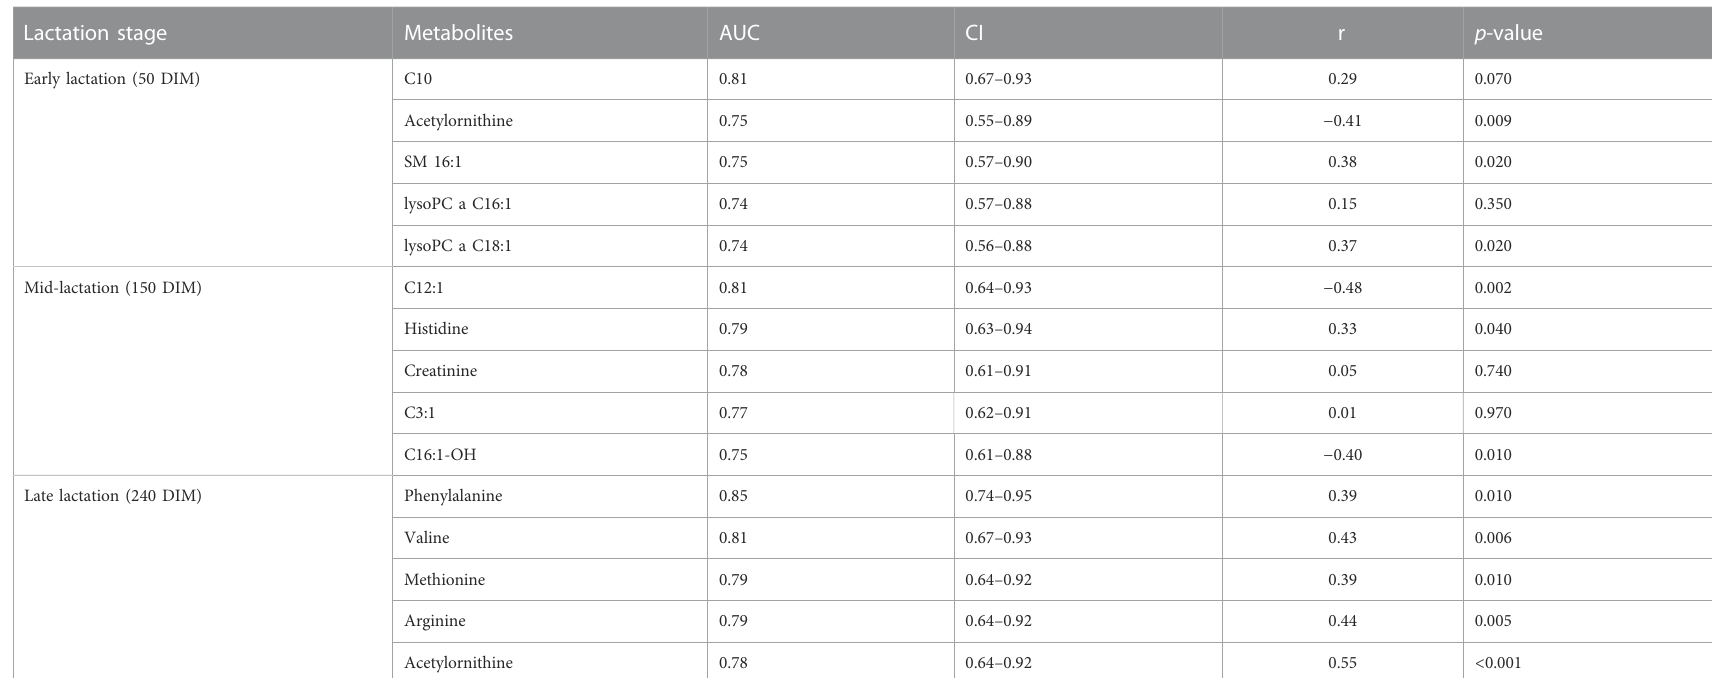
TABLE 5 Top 5 metabolites (biomarkers) with corresponding AUC and CI at early, mid and late lactation stages. The correlation between the candidate biomarkers ’ concentration in milk and the RFI values is shown in Pearson correlation coef fi cient (r) and p